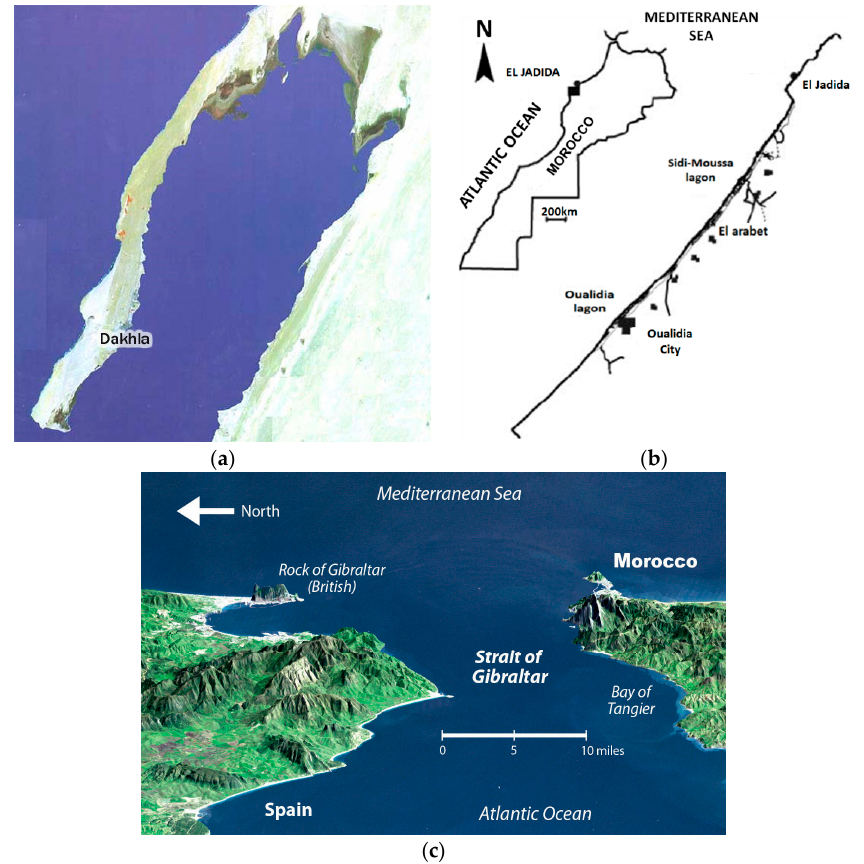
Figure 4. Potential areas for tidal power generation in Morocco. ( a ) Dakhla bay (23°30 ′ N; 16° W) [31]; ( b ) Oualidia lagoon (32°45 ′ N; 9°3 ′ W) [32]; ( c ) The southern coast of the Strait of Gibraltar [33].